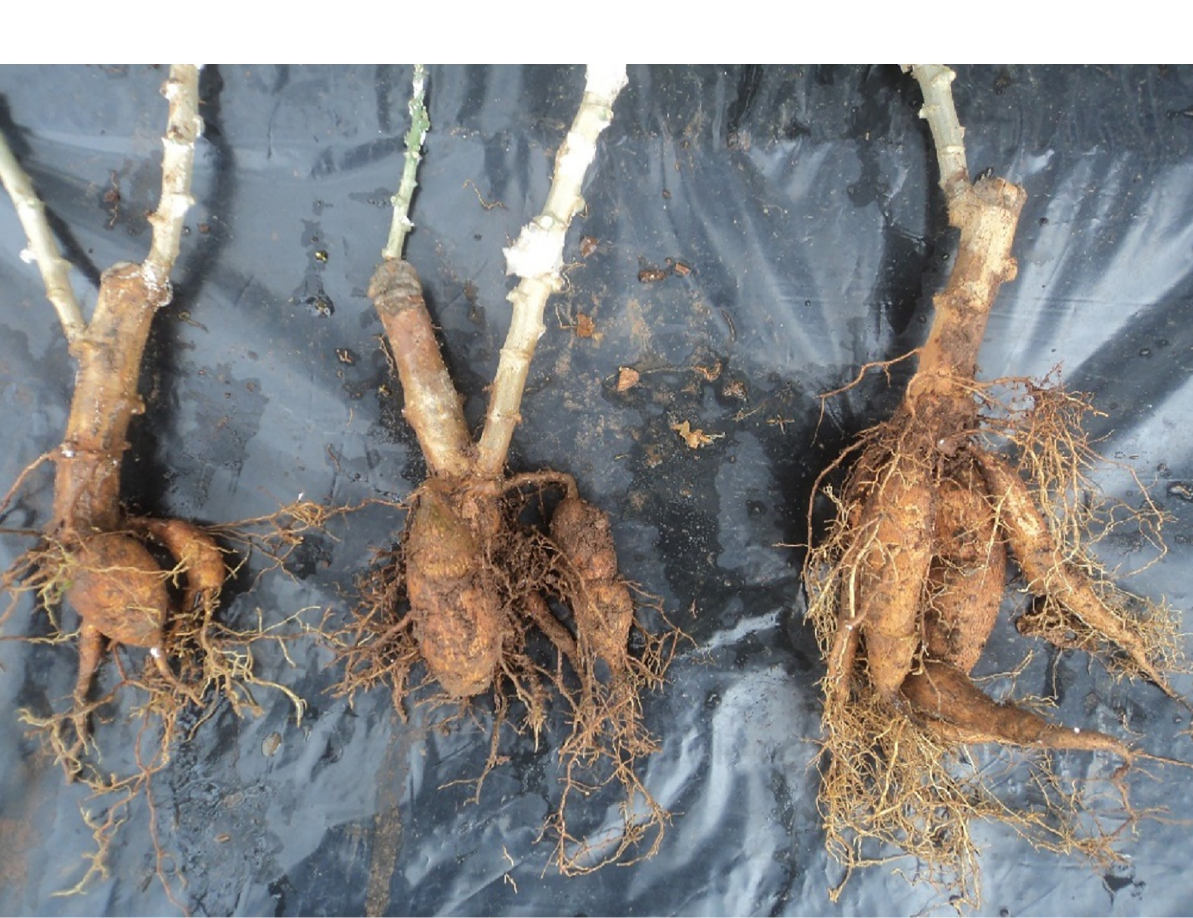
Fig 3. Cassava roots system, according to inoculum dose of inoculated plants of BEN86052, 3 months after inoculation.